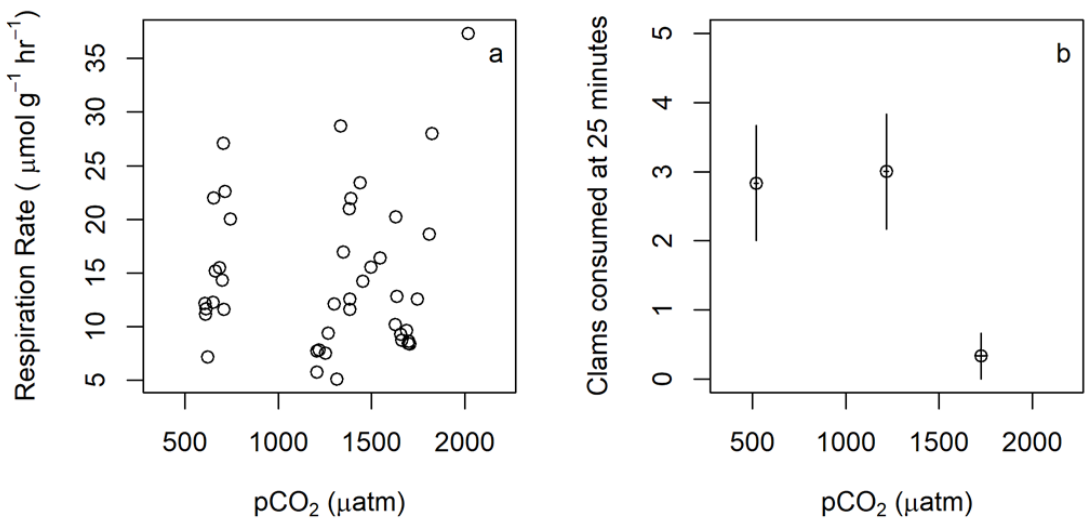
Figure 5. ( a ) Respiration and ( b ) feeding rates of the signal crayfish as a function of pCO 2 . High pCO 2 inhibits feedings rates for the crayfish, while respiration rates do not significantly vary across pCO 2 treatments. Vertical bars represent standard error of respiration rates for of feeding rates for six crayfish per treatment; horizontal bars represent standard deviation of pCO 2 for the respective treatments.